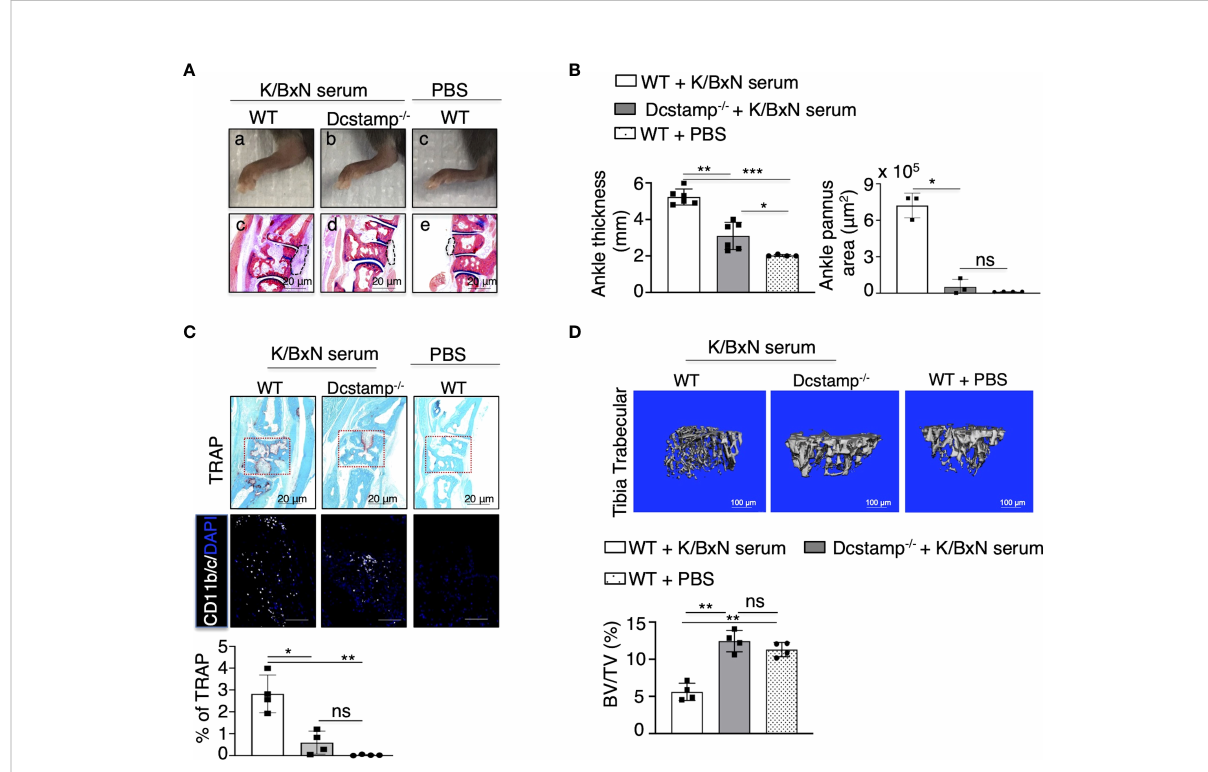
FIGURE 4 DC-STAMP modulates ankle in fl ammation in an acute mouse model of RA. 8-weekold C57BL/6 mice were injected, at days 0 and 3, with 150 ul of serum collected from 8-week-old K/BxN mice. Dcstamp -/- mice show (A, B) a signi fi cant reduction in ankle thickness and pannus area, lower TRAP deposition, diminished tissue in fi ltration by in fl ammatory cells ( C lower panel) and signi fi cantly lower bone density in the tibia (D) * p < 0.05, ** p < 0.005, *** p < 0.0001 (Two-way ANOVA and Student's t-test). Representative 200x magni fi cation pictures were taken with Zeiss Axioplan microscope and recorded with Hamamatsu camera. Scale bars represent 20 m m. ns, not statistically signi fi cant (paired Student's